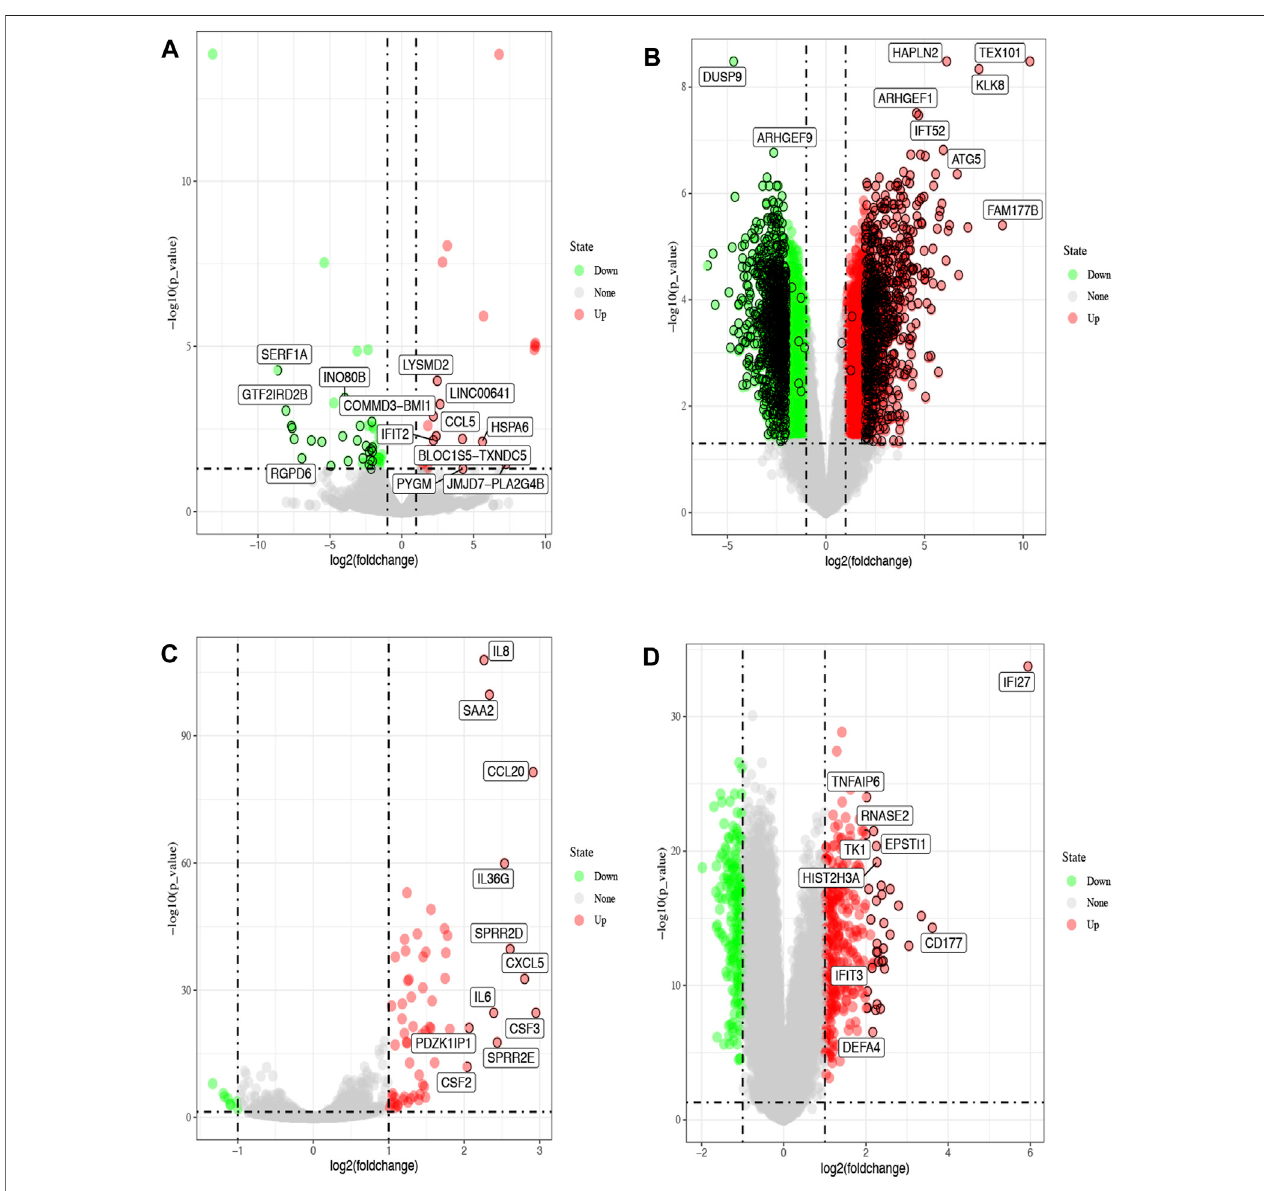
FIGURE 1 | Volcano plots of differentially expressed genes (DGEs) from the GEO database. The red dots represent up-regulated genes, green represent down- regulated (FDR < 0.05, |log2FC| > 2). Differentially expressed genes of COVID-19 from GSE147507 (A) and GSE164805 (B) . Differentially expressed genes of in fl uenza from GSE147507 (C) and GSE101702 (D)